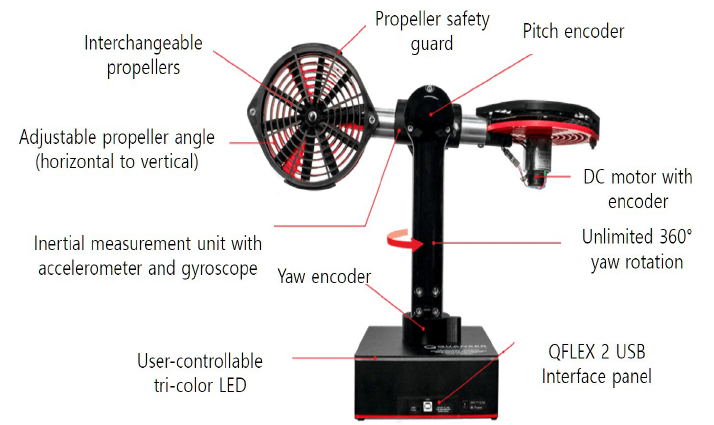
Figure 2. Quanser Aero 2-DOF Helicopter